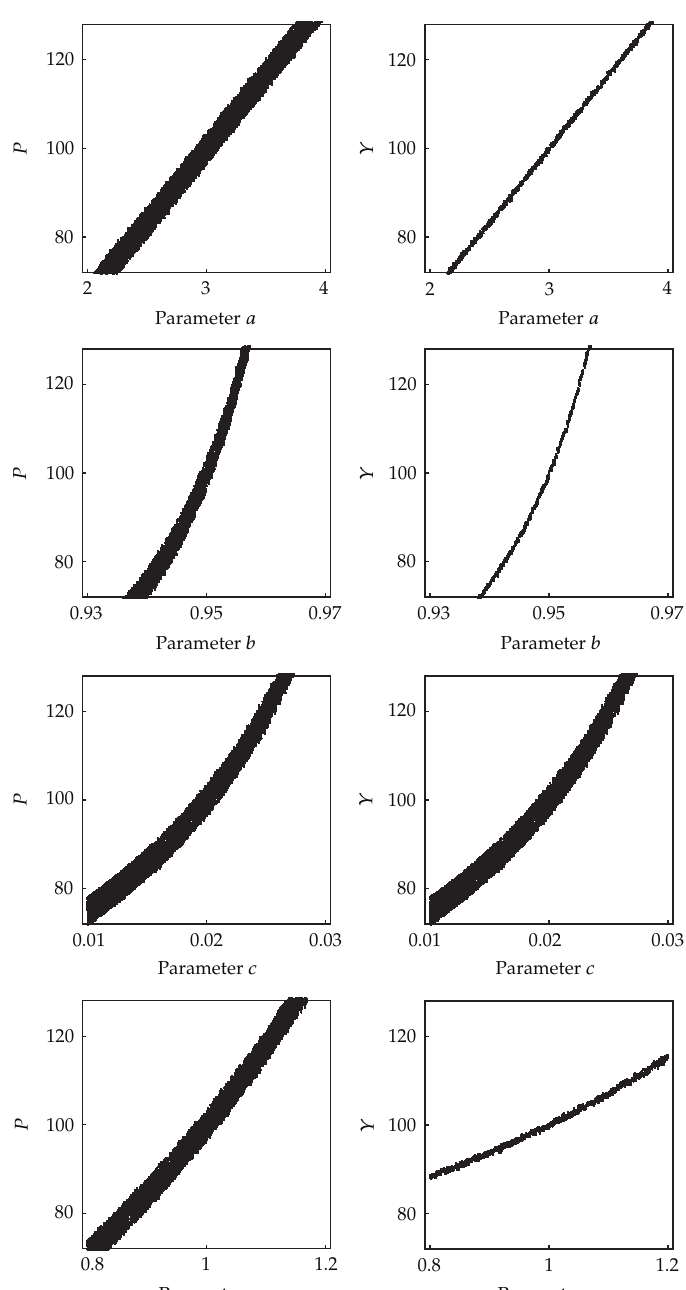
Figure 4: Real forces and the dynamics of the complete model. Parameter setting as in Section 4. Bifurcation parameters as indicated on the